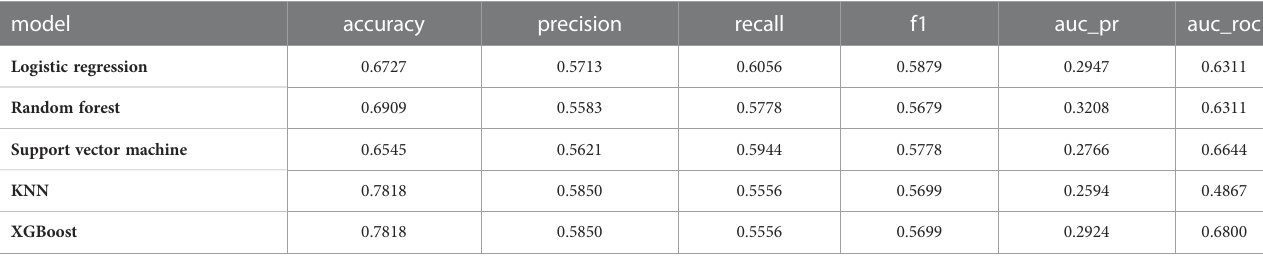
TABLE 4 Results of the testing sets using fi ve machine learning